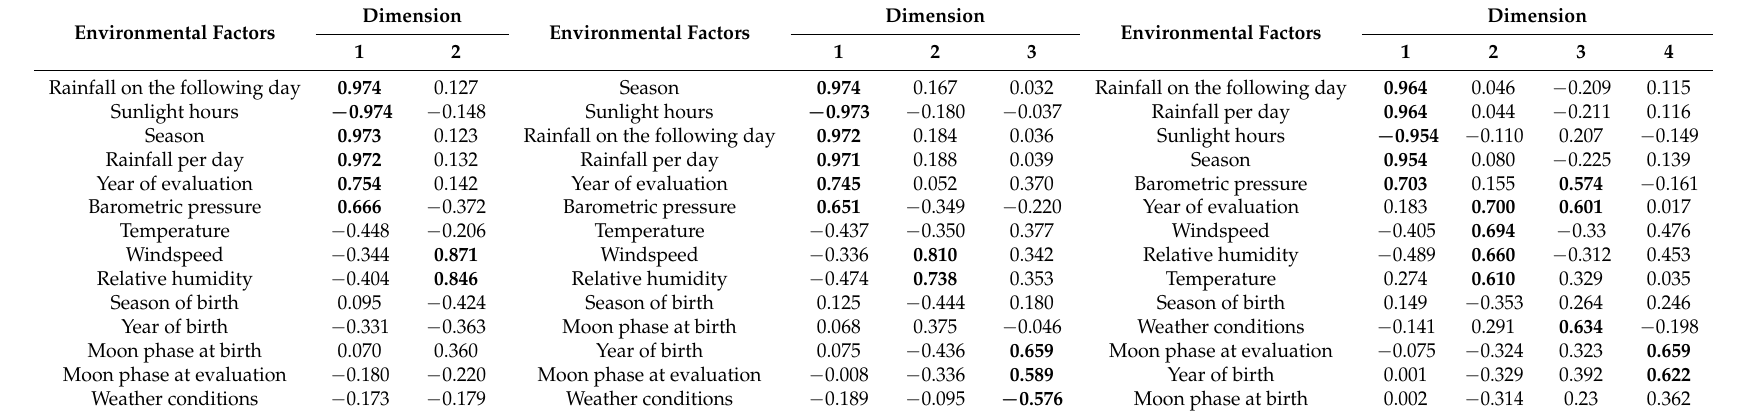
Table 7. Categorical principal component analyses (CATPCA) component